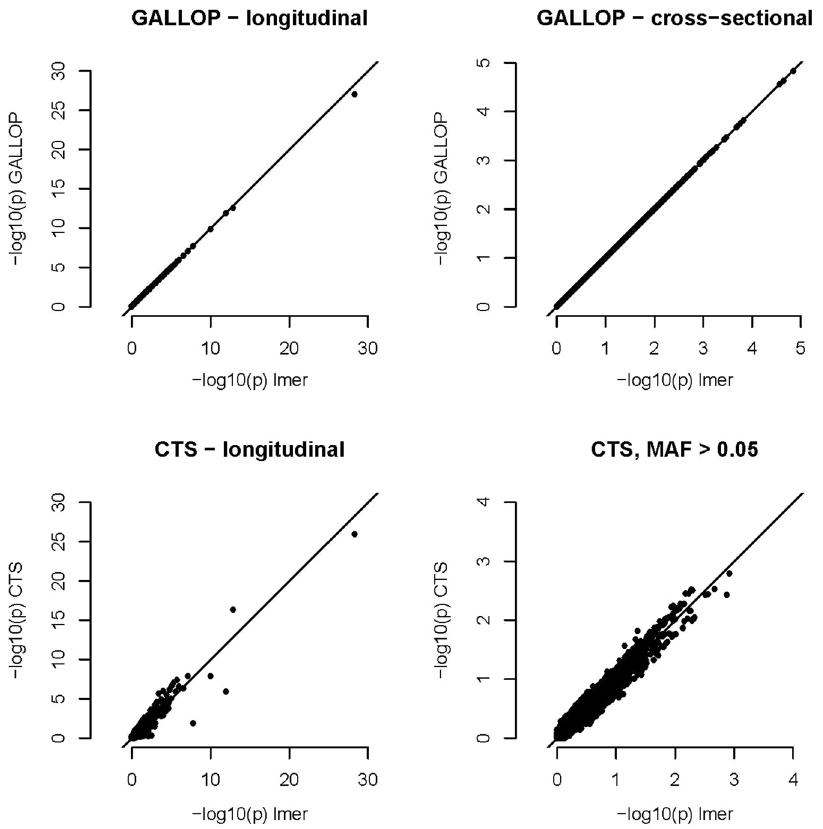
Figure 4. BMD data. Accuracy of the p-values for the GALLOP and